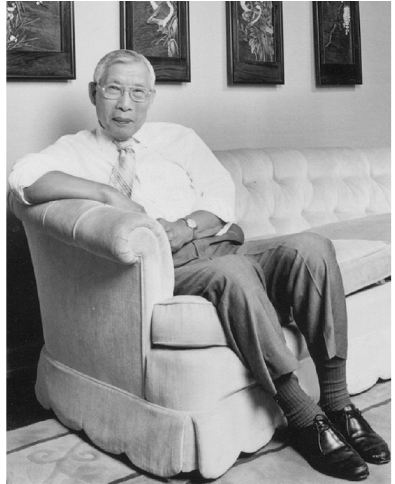
Figure 1. Ching Chun Li (1912 –